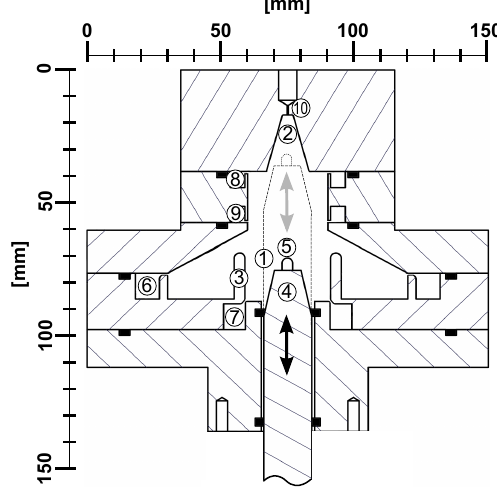
Fig. 4. Schematic of the radial collection and desorption unit with NiCr filament in collection position: (1) collection region, (2) des- orption region, (3) collection tube, (4) PEEK piston, (5) collection filament, (6) aerosol inlet, (7) collection flushing inlet, (8) desorp- tion flushing inlet, (9) exhaust and (10) screw connection for trans- fer capillary. Positions of O-rings are shown in